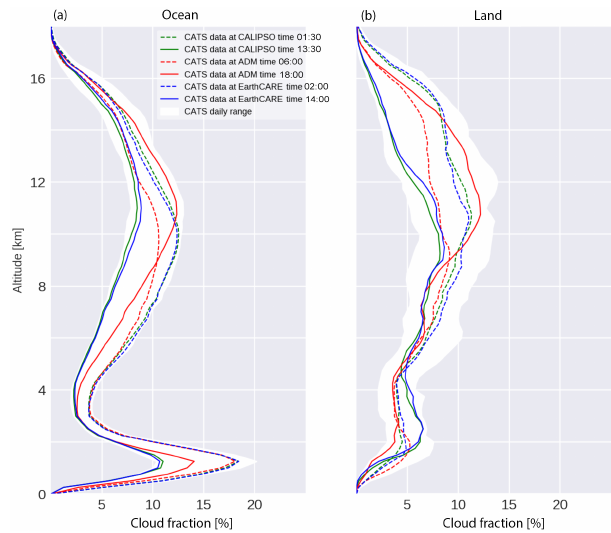
Figure 8. Mean cloud fraction profiles observed by CATS at the overpass local time of the sun-synchronous space lidars (CALIPSO and the A-Train 01:30UTC, ADM 06:00UTC, Earth- CARE 02:00UTC) compared to the envelope of the whole cloud fraction profile diurnal cycle observed by CATS (white), averaged between ± 51 ◦ over ocean (a) and land (b) . CALIPSO and Earth- CARE are dedicated to clouds and aerosols studies, while ADM is primarily dedicated to wind measurements in non-cloudy condi- tions. We used CATS observations during JJA from 2015 to